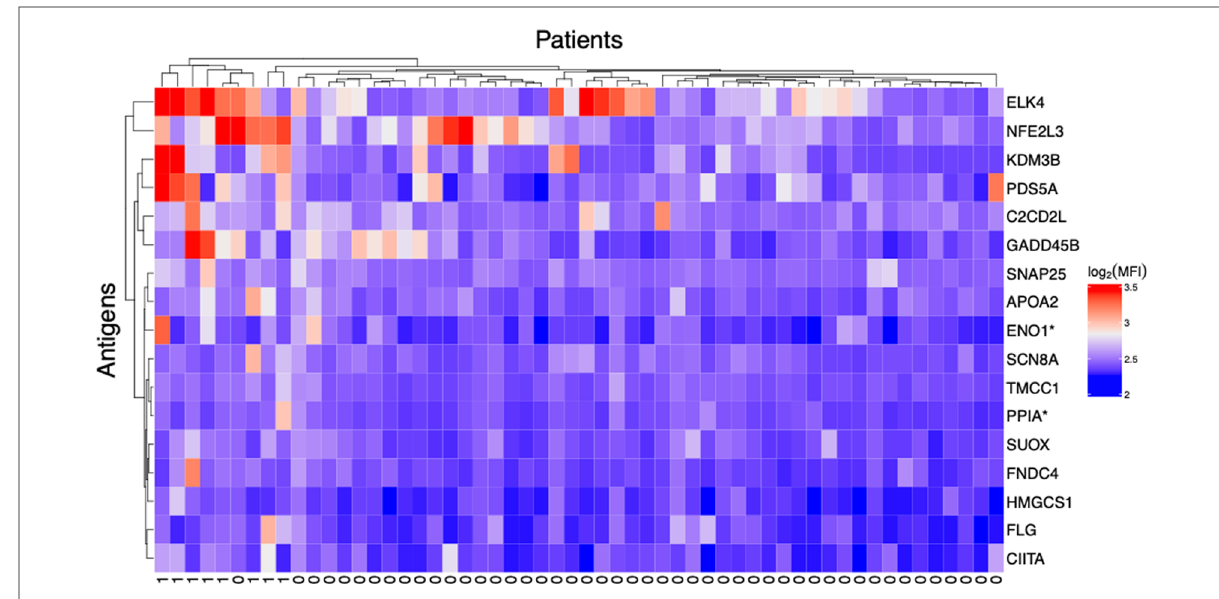
FIGURE 4 JIA patients with uveitis cluster together based on their autoreactivities. Hierarchical clustering analysis of reactivity towards the 17 peptides signi fi cantly different between patients with and without uveitis. Hierarchical clustering is based on MFI distances. Bottom row indicates uveitis (0=no,